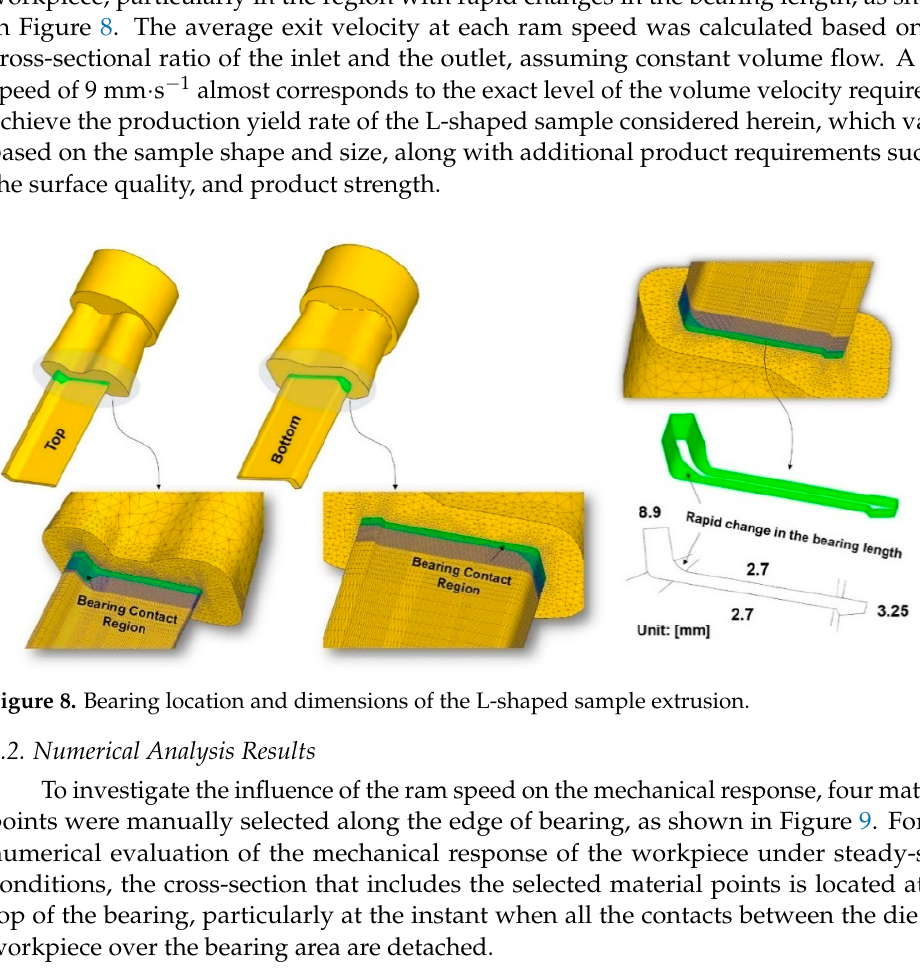
Figure 9. Locations used to evaluate the mechanical responses with the variation in ram speed.